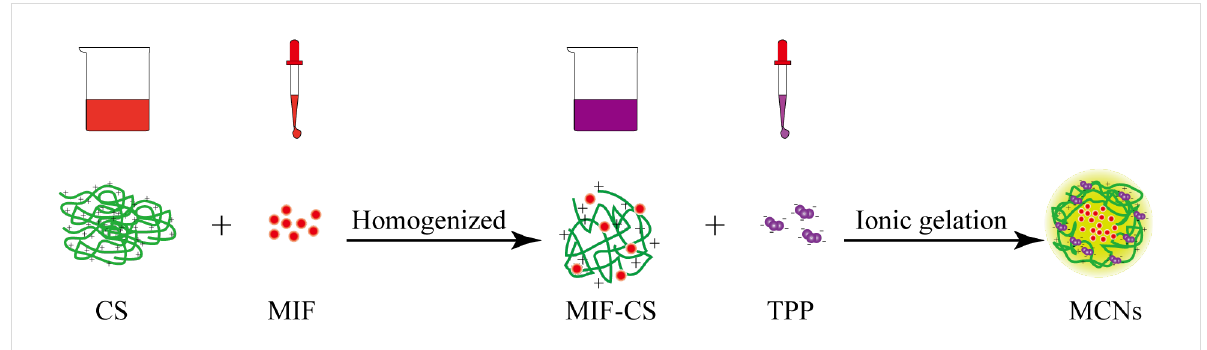
Figure 1: Schematic illustration of the preparation procedure for MCNs. MIF-loaded CNs were prepared by a convenient ionic gelation technique. Cs was firstly mixed with MIF to afford a homogeneous solution then interacted with a TPP solution to allow MIF to be encapsulated during the ionic gelation